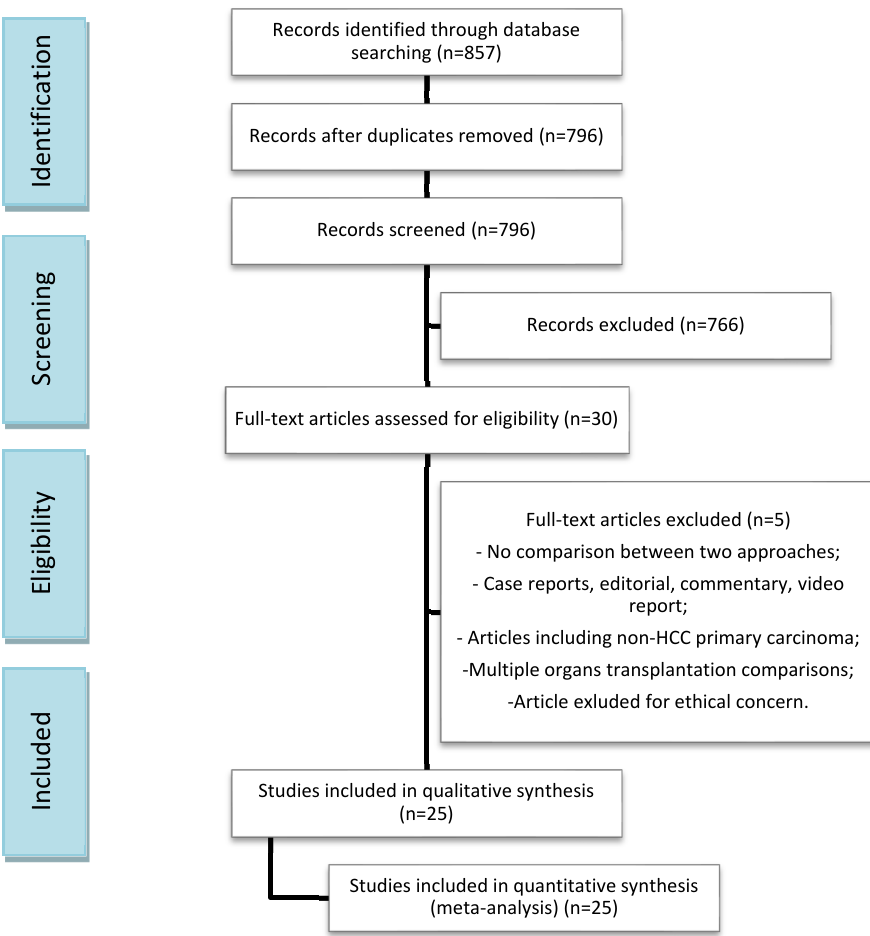
Figure 1. Search flow